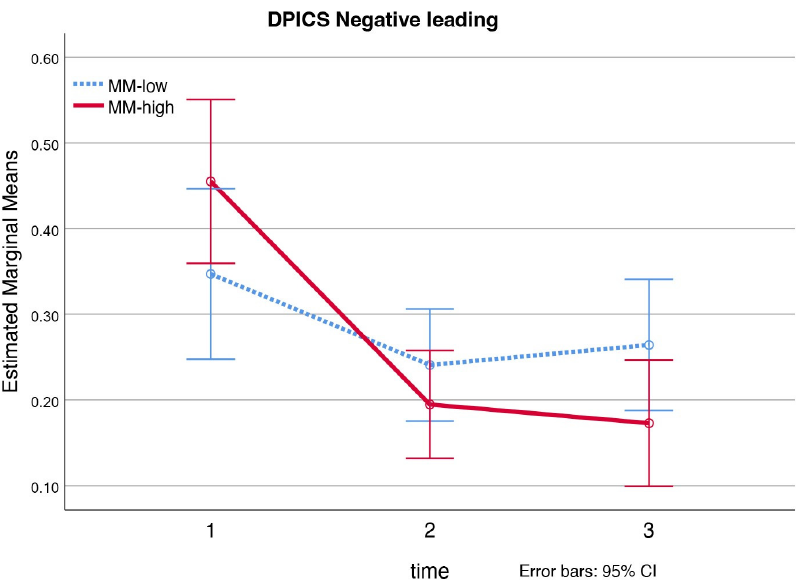
Figure 2. PCIT-Clinic: interaction effect for DPICS negative leading. Note. MM-low = mothers with a medium-low level of mind-mindedness; MM-high = mothers with a medium-high level of mind- mindedness. Table 3. PCIT-Clinic repeated measures ANOVA results ( F -values, p , partial eta squared ( η p2 )). Intervention Group (MM) Interaction (MM)